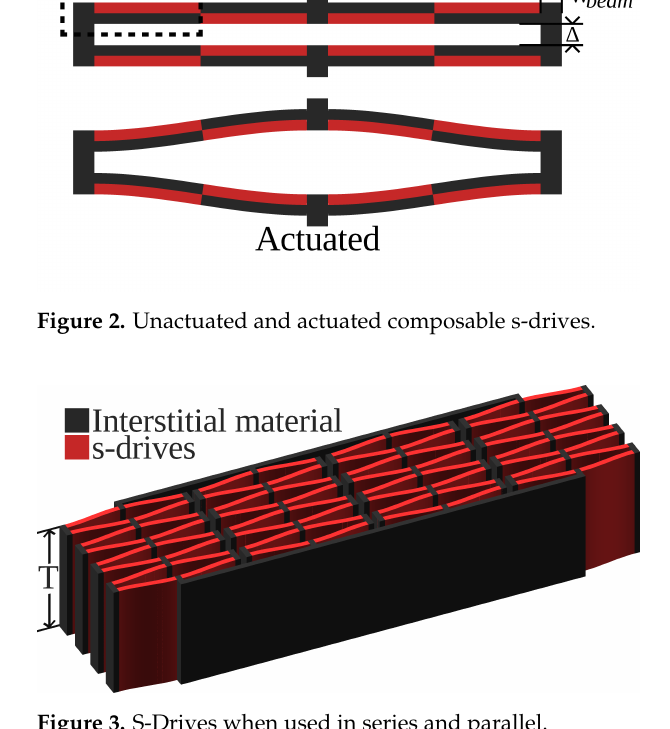
Figure 3. S-Drives when used in series and